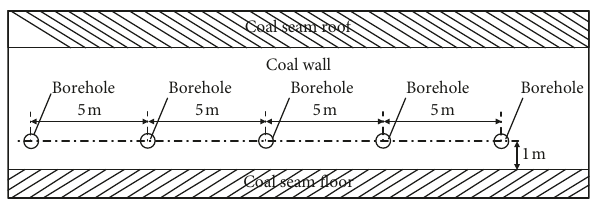
Figure 4: Borehole arrangement method.